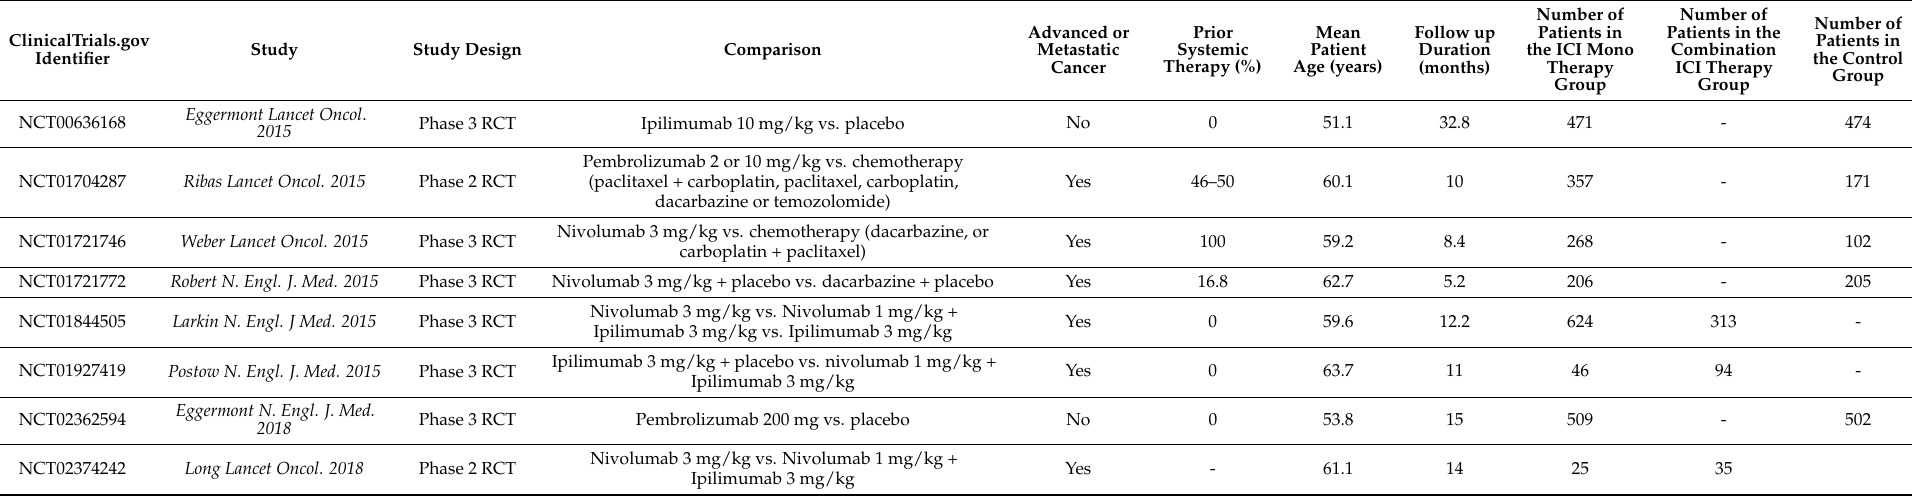
Table 1. Characteristics of the included randomized clinical